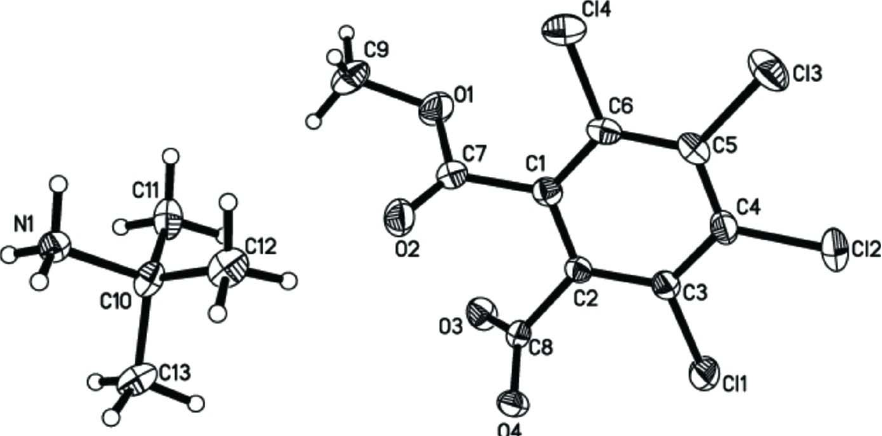
Figure 1 The molecular structure of (I), drawn with 30% probability